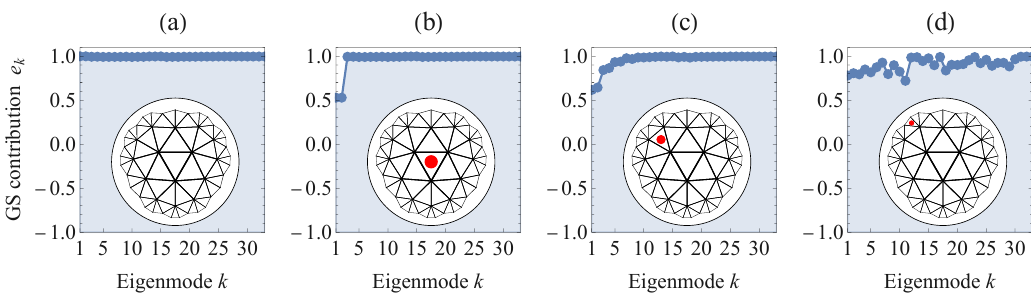
Figure 14 . Ground-state mode contributions e k for local bulk excitations in the { 3 , 7 } matchgate tensor network at different bulk sites. (a) No excitation. (b)-(d) Excitation on single tile (red dot) belonging to different inflation layers. Modes are sorted by their energy eigenvalue λ k relative to the mode-disordered Ising Hamiltonian H MDI corresponding to the tiling with N = 33 boundary sites ( n = 2 inflation